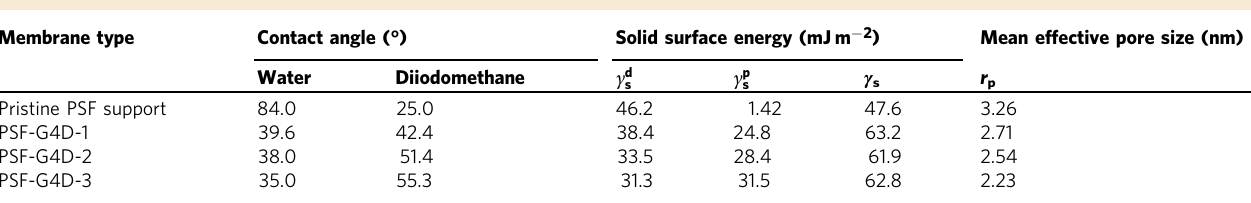
Table 2. Separation performance measurements were conducted